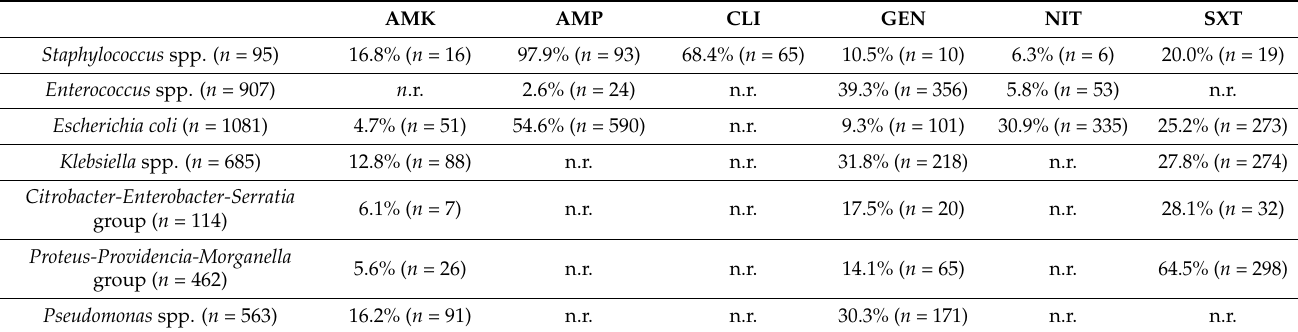
Table 5. Percentage of resistant isolates from inpatient UTIs against WHO Access